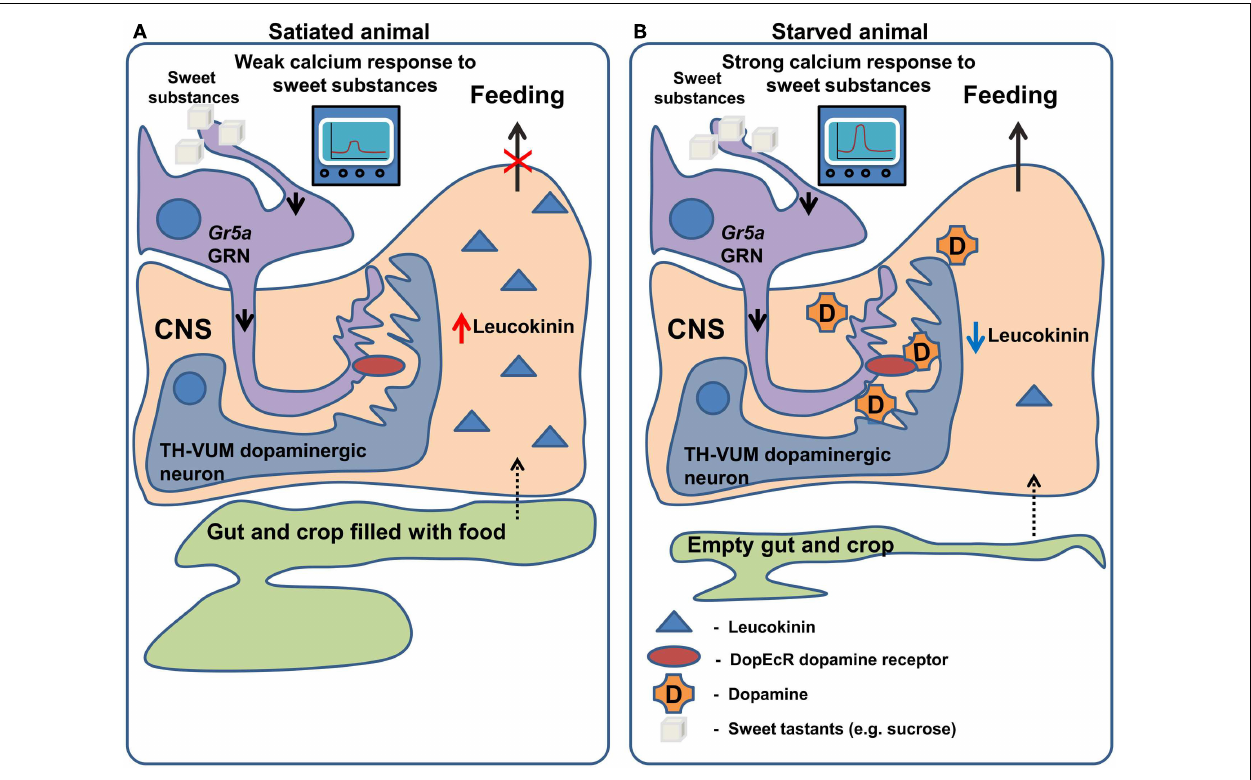
weak response to “sweet” compounds. (B) In starved animals, the spiking activity ofTH-VUM neurons is increased leading to dopamine release on the Gr5a expressing GRNs. In these GRNs dopamine binds to the DopEcR receptor causing increase in the calcium response to “sweet” compounds. As the crop and gut are empty leucokinin release is inhibited and feeding termination does not